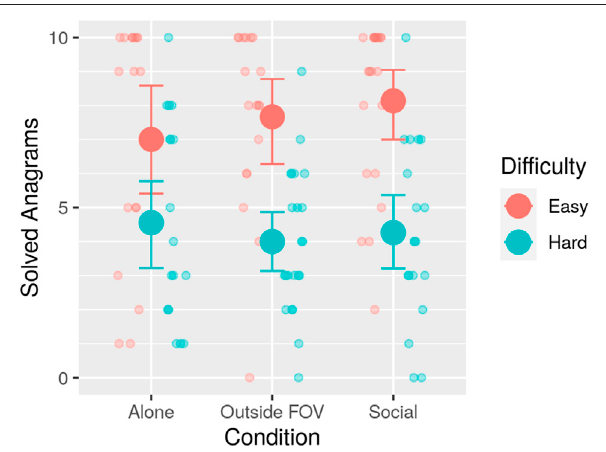
FIGURE 4 | Larger points represent means; smaller transparent points represent individual entries. Error bars are 95% bootstrapped con fi dence intervals of the mean. While the trends of social facilitation and inhibition are present, i.e., more easy anagrams and fewer hard anagrams are solved in the social condition than in the alone condition, the difference is not signi fi cant.